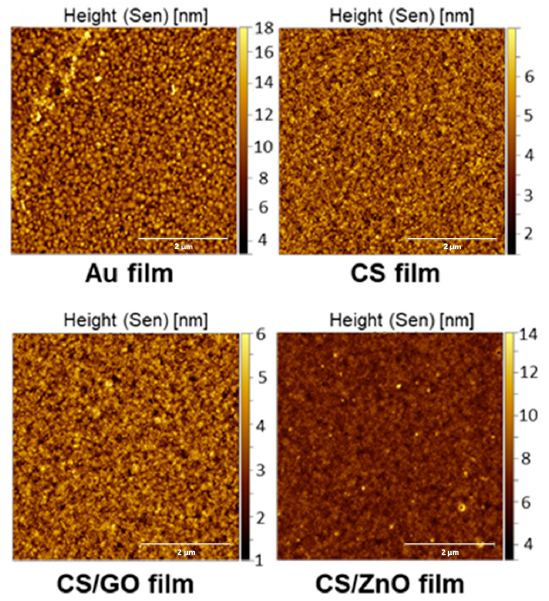
Figure 5. AFM images of Au electrode, CS, CS/GO, and CS/ZnO composite thin films cross-linked by GA.